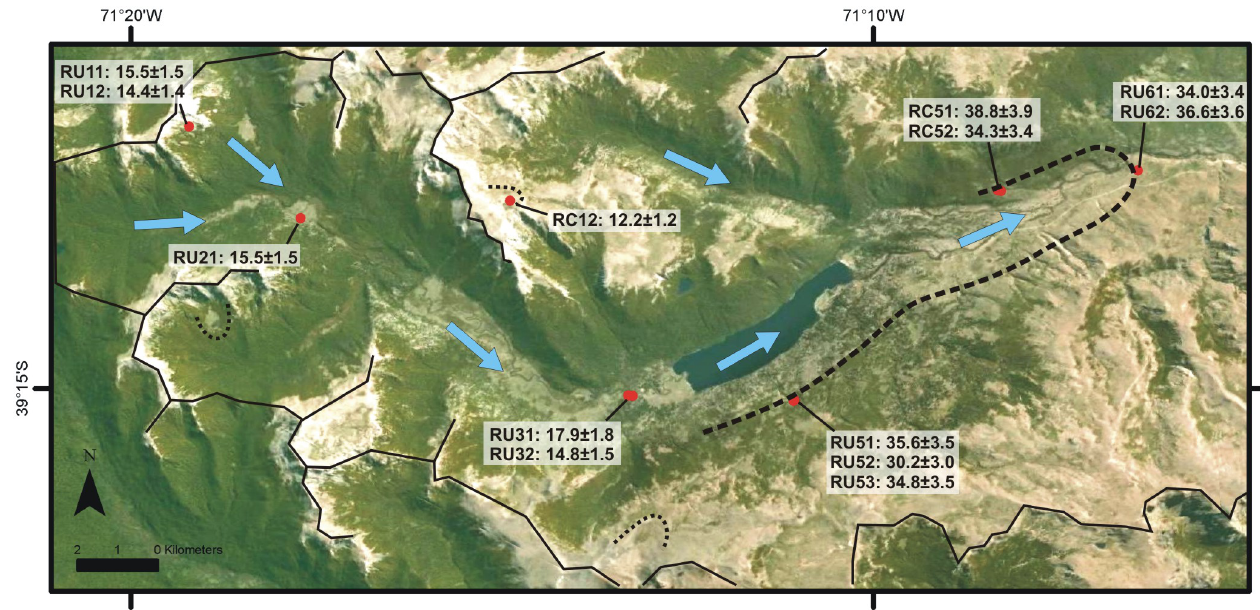
Fig. 2. Landsat image of the Rucachoroi Valley with sampling locations (red dots) and surface exposure ages [ka]. Blue arrows indicate the former ice flow direction, the dashed line marks the prominent lateral and lateral-frontal moraine, and dotted lines mark cirque moraines. Continuous thin lines demarcate the catchment